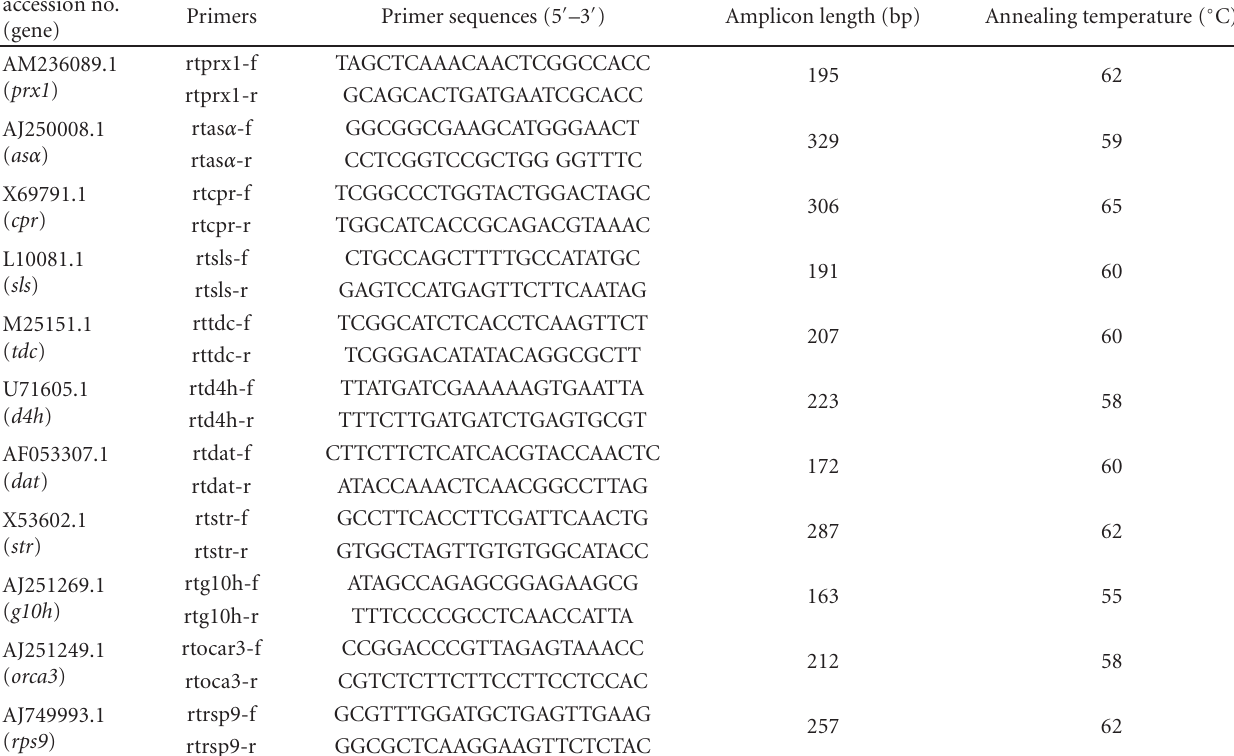
Table 2: Genes and their primer sequences used for real-time